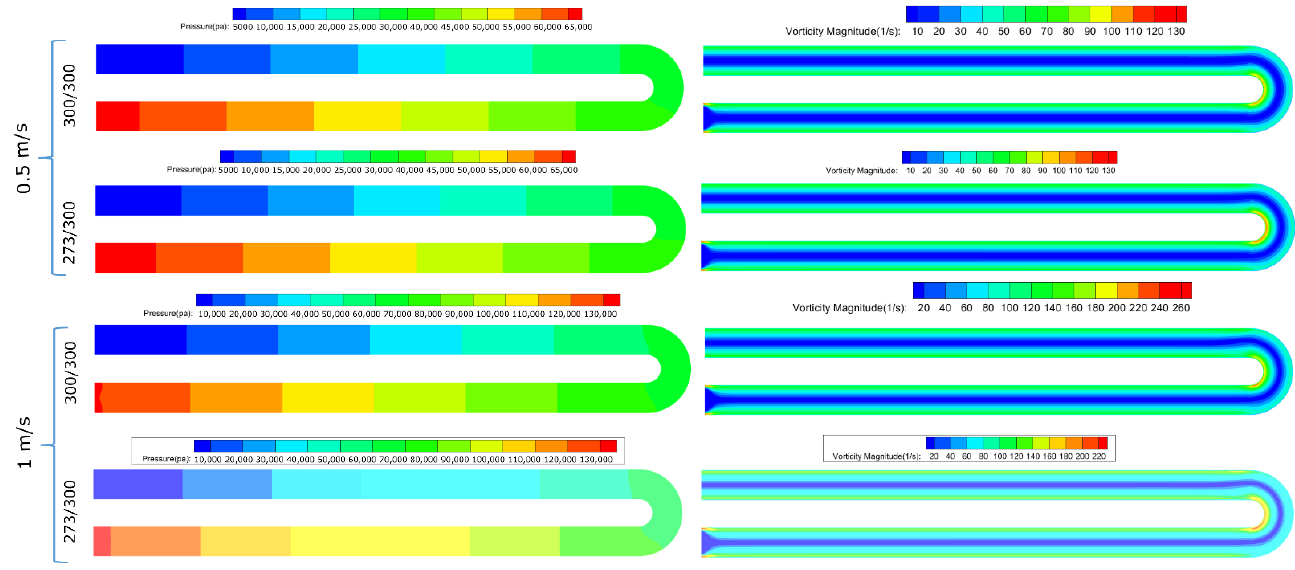
Figure 4. The pressure and the vorticity magnitude at the middle-height plane of the U-shaped channel. The pressure is displayed in the left column, and the vorticity magnitude is displayed in the right column. The first row shows the data at the inlet velocity of 0.5 m/s with no temperature difference. The second row shows the results at the inlet velocity of 0.5 m/s but at the temperature conditions of 273 K on the wall and 300 K of the incoming fluid at the inlet. The third row shows the results at the inlet velocity of 1 m/s with no temperature difference. The fourth row shows the results at the inlet velocity of 1 m/s but at the temperature conditions of 273 K on the wall and 300 K of the incoming fluid at the inlet.